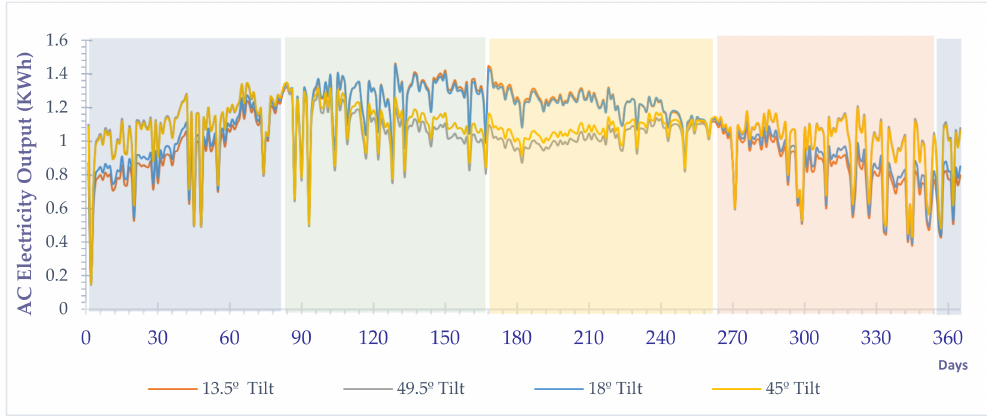
Figure 7. Impact of the tilt angle on the PV panel’s electricity Output in each